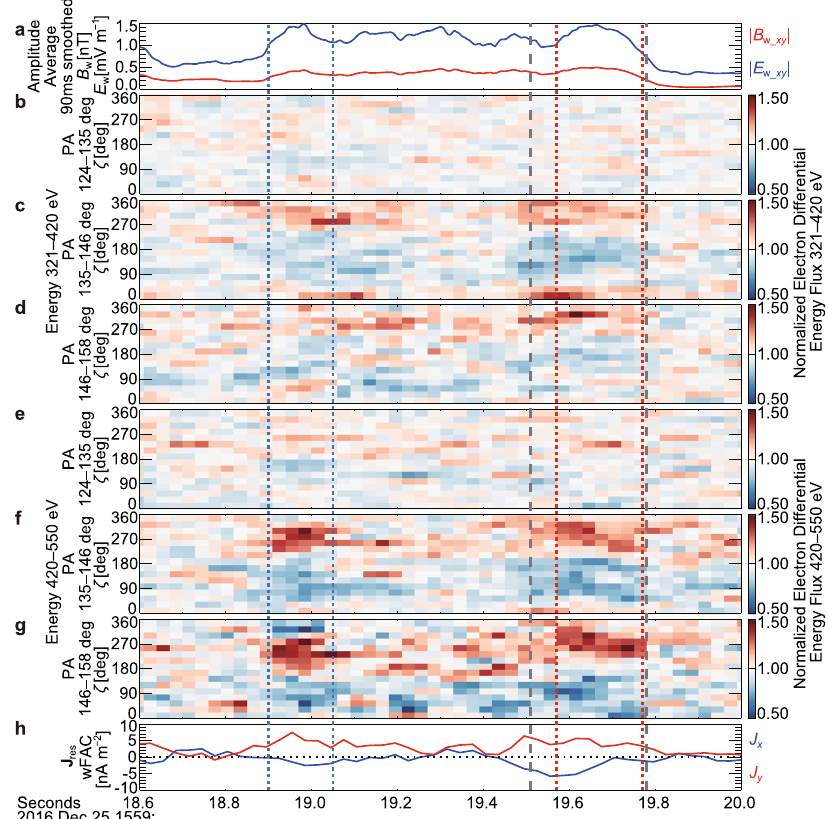
Fig. 4 | Temporal variation of nongyrotropic electrons at multiple energy and pitch angle bins and the resonant current (Event 1). a Amplitude of wave com- ponent of the magnetic fi eld ( B w ) and the electric fi eld ( B w ) in the fi eld-aligned coordinate (FAC) x - y plane. Moving-average values from all four spacecraft mea- surements with a window of 90ms, which is comparable with the window for the analysis of electron data (3 temporal bins (see Methods, subsection Electron and